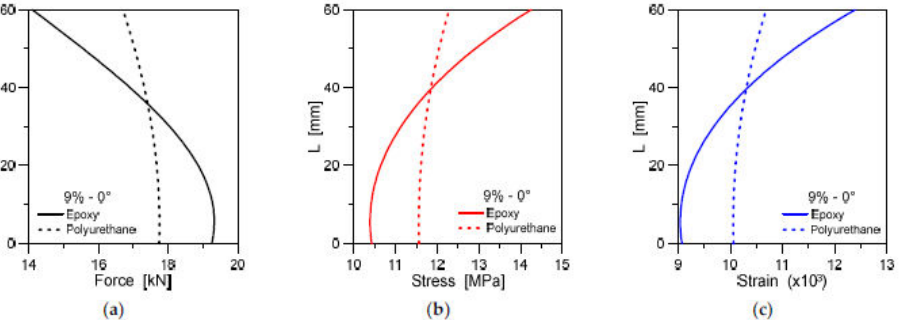
Figure 14. Analytical prediction of shear ( a ) force, ( b ) stress and ( c ) strain in BiR connections with epoxy or polyurethane adhesives (examples for 9% moisture and parallel rod-to-glue